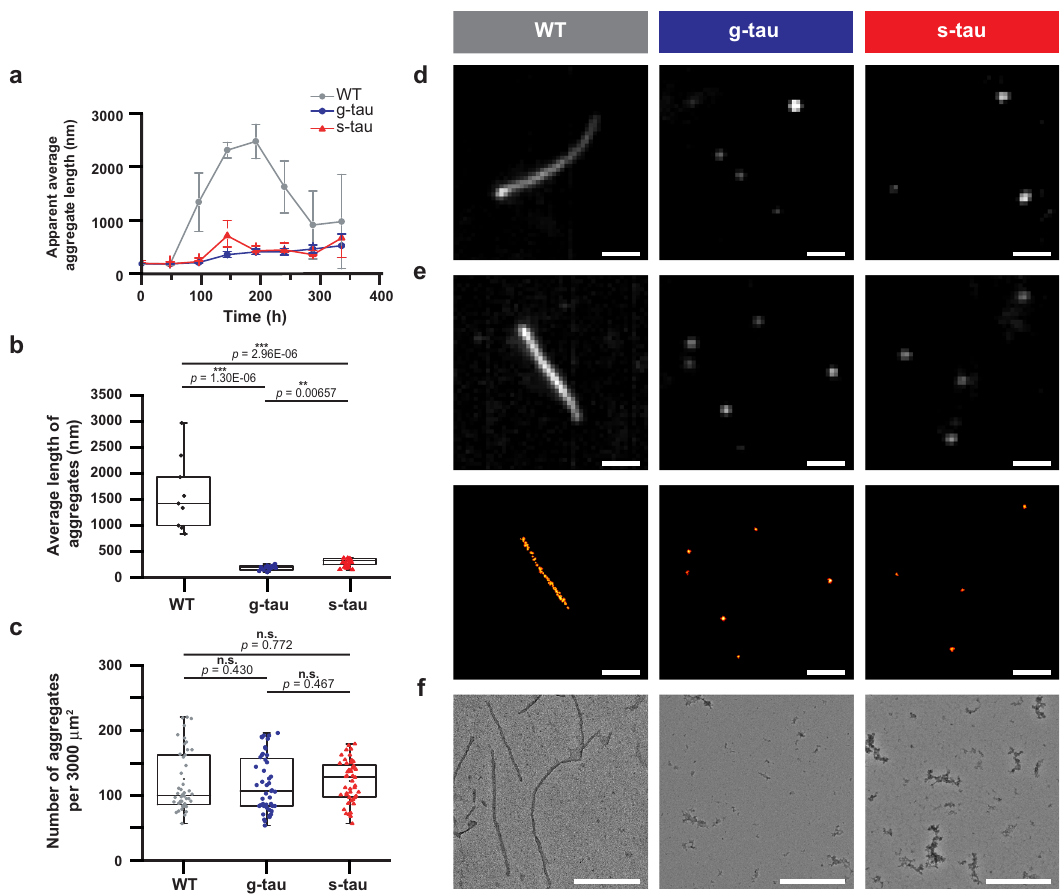
Fig. 2 Hyperphosphorylation enables WT tau to self-polymerize into small amorphous aggregates without external inducers. a The apparent average length of tau aggregates, monitored by fl uorescence microscopy, was analyzed, and plotted as a function of time (data are presented as mean values ± s.d. across three independent experiments for each tau species). b Summary plot based on our results from super-resolution microscopy indicated that at 96 h of incubation the average length of heparin-induced WT aggregates (1450 ± 700 nm) was signi fi cantly larger than both g-tau (190 ± 50 nm) and or s-tau (280 ± 90 nm) ( n = 9 across three independent experiments for each tau species). c Summary plot based on our results from fl uorescence microscopy indicated the number of aggregates was not signi fi cantly different among these three tau species ( n = 48 across three independent experiments for each tau species). d Representative pFTAA diffraction-limited images of different tau species after 96 h of incubation: while WT tau under the induction of heparin grew into fi brillar aggregates, both g-tau and s-tau self-assembled into small, non- fi brillar aggregates which largely remained as diffraction-limited spots. Scale bar: 1.0 μ m. e Representative ThX stacked and super-resolved images of different tau species after 96 h of incubation. Scale bar: 1.0 μ m. f Morphological examination of all three tau species by TEM after 96 h of incubation. Scale bar: 500 nm. For b and c , boxplots represent median value and interquartile range (25 – 75% percentiles) excluding outliers. The P -values are based on unpaired two-sided Student ’ s t -test: *** p < 0.001; * p < 0.05; n.s. non-signi fi cant. For d – f , images were representative across three independent experiments for each tau species. Source data are provided as a Source Data fi